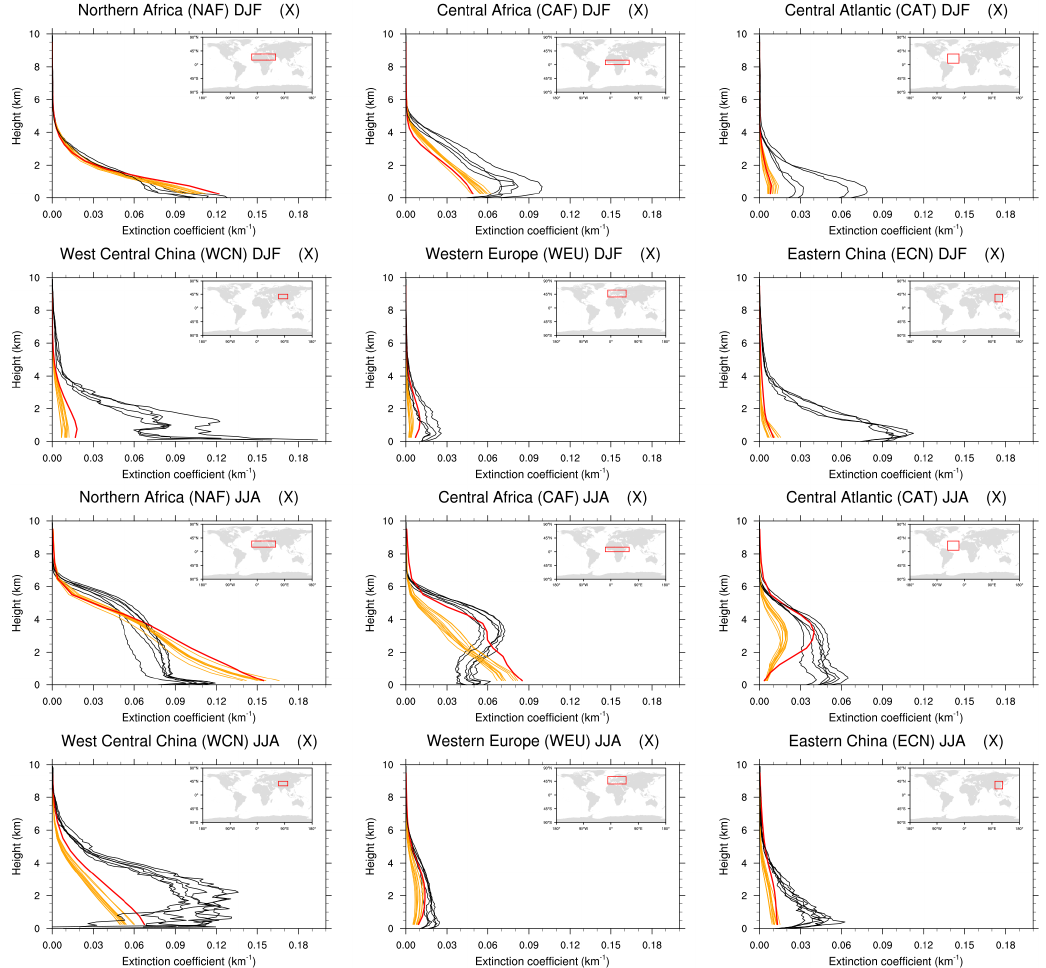
Figure 18. Mean vertical profiles of extinction coefficients (km − 1 ) for the dust aerosol, for the FreSimd2 simulation (orange lines) for 2004 (repeated 10 times), the NudSimd2 simulation (red line), and for individual years of the CALIOP 3-D product (black line), over six regions of the globe with dust aerosols (as in Koffi et al., 2012), for DJF (rows 1 and 2) and JJA (rows 3 and